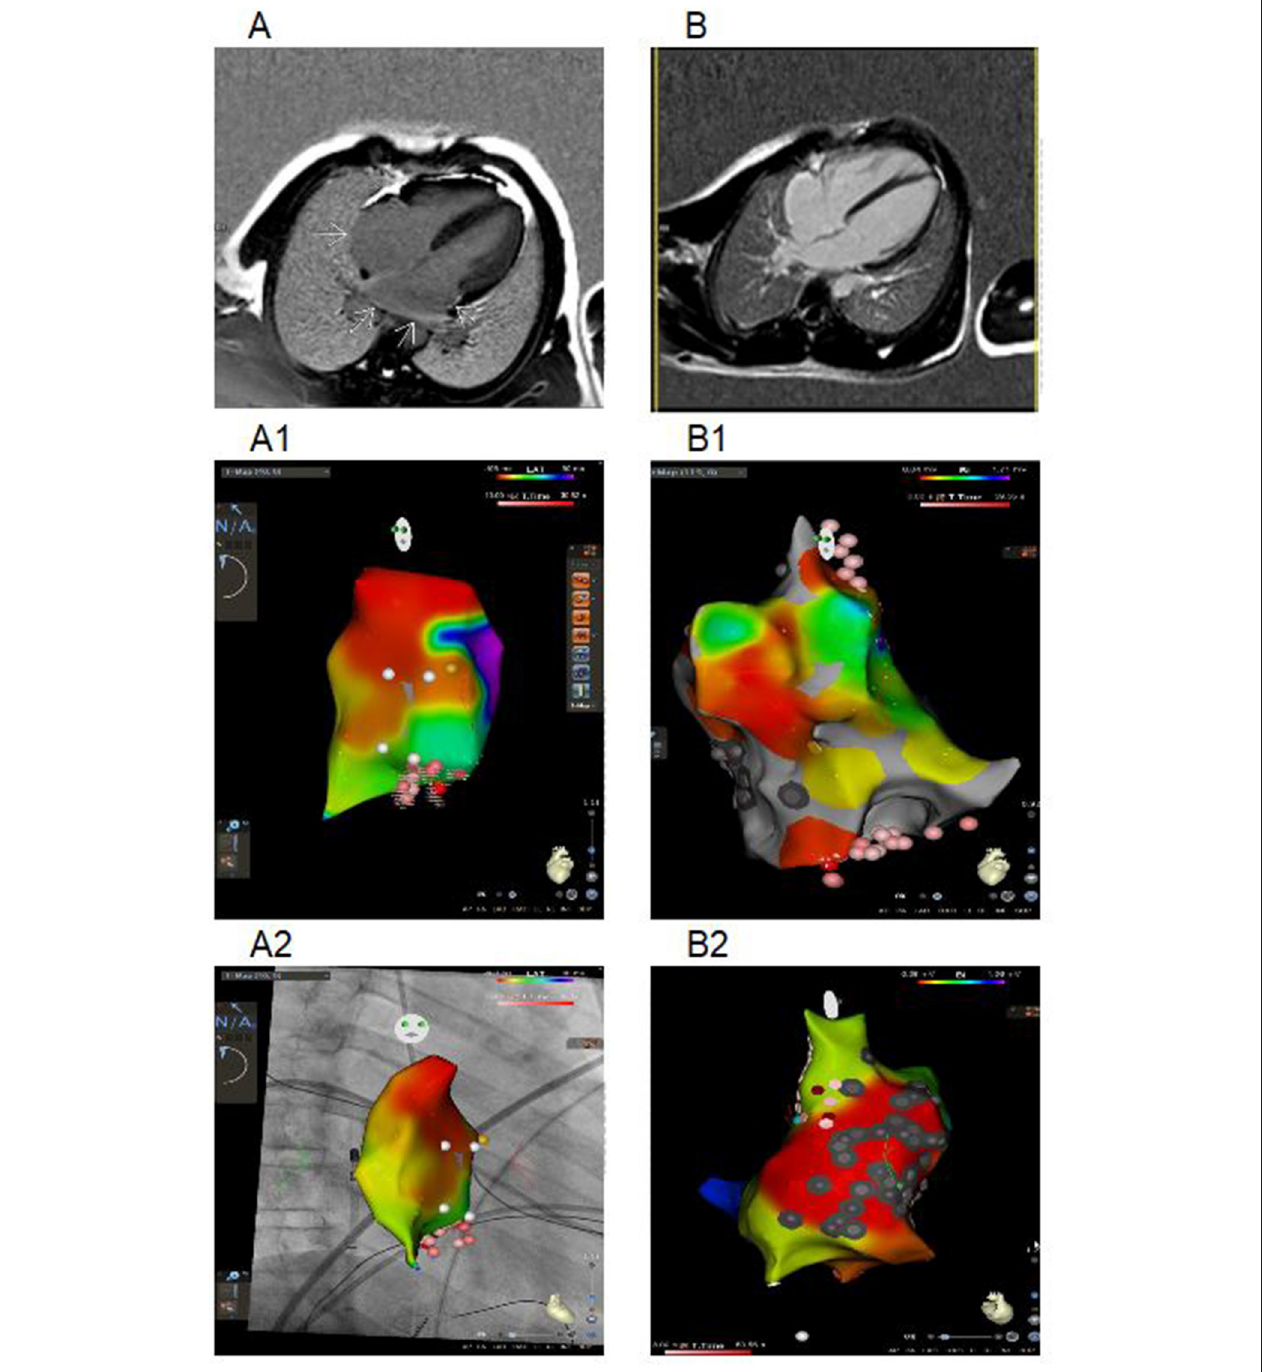
FIGURE 1 | Cardiac maps using three-dimensional mapping system and CMR (imaging in the 4-chamber plane) of Patient 1 and 2. (A) CMR from a patient 1: delayed-enhancement CMR shows areas of myocardial scarring in both atria (arrows). (A1) Right atrial activation map (CARTO 3 system), LAO position. White dots – location points, yellow dots – part of conduction system, red and pink dots – RF ablation points (the degree of color intensity depends on the RF exposure time). (A2) Right atrial activation map (CARTO 3 system with CARTOUNIVU module), RAO position. White dots – location points; yellow dots – part of conduction system, red and pink dots – RF ablation points (the degree of color intensity depends on the RF exposure time). (B) CMR from a patient 2 with RA dilatation. (B1) Bipolar map of right atrium (CARTO 3 system), LAO position. (B2) Bipolar map of right atrium (CARTO 3 system), non-standard position with focus on the scar and ablation sites. Gray dots – scar points, white dots – location points, blue dots – double potential, red and pink dots – RF ablation points (the degree of color intensity depends on the RF exposure time). Bipolar color scale: red fill color has the lowest voltage.